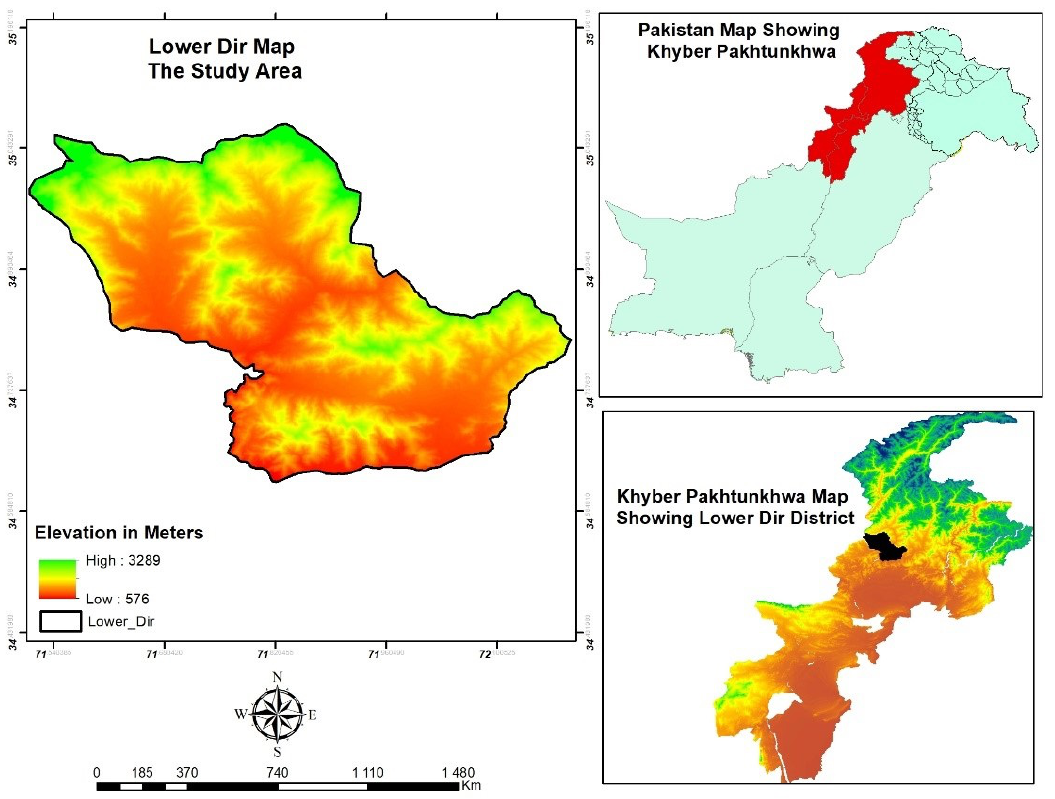
Figure 1. Map showing the location of study area, district Lower